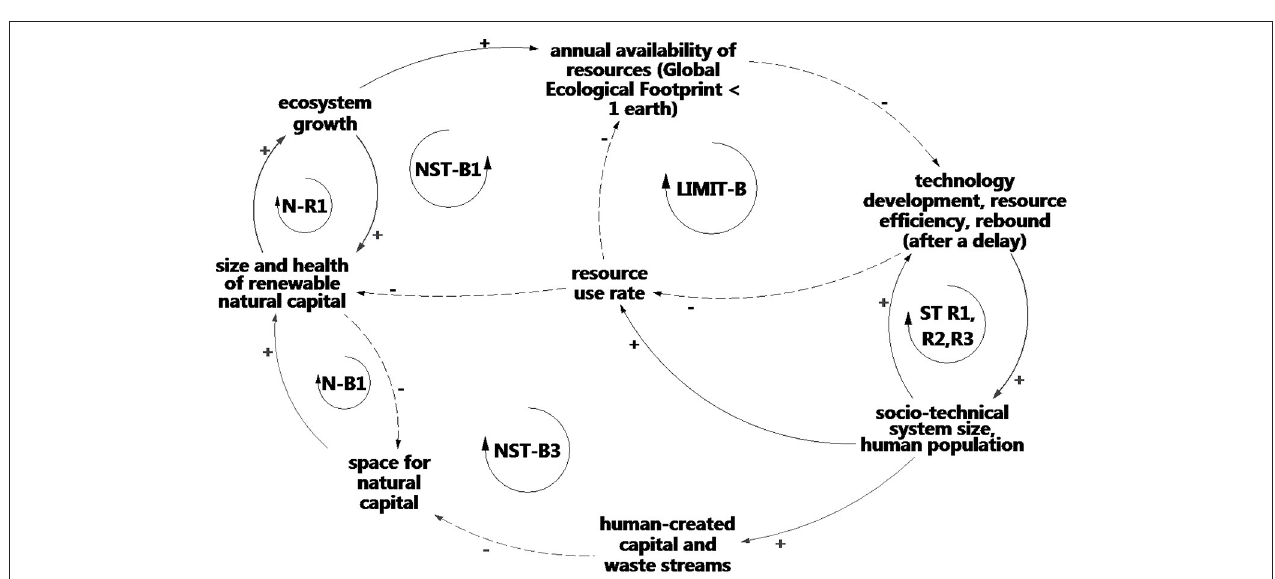
Table 6 outlines how different types of rebound might change in storyline